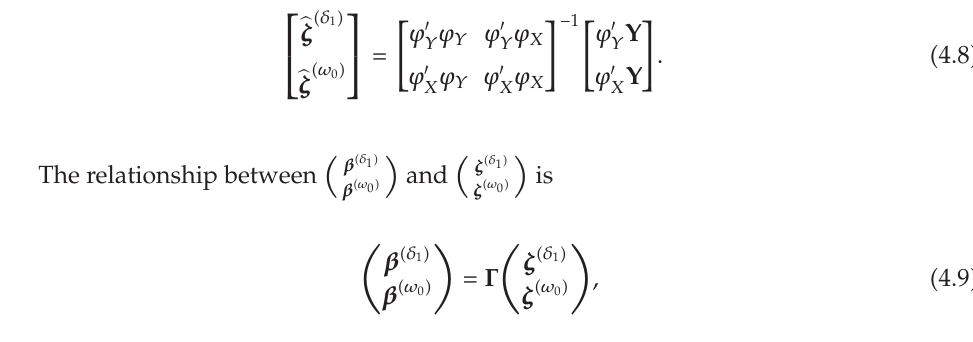
(cid:5) δ (cid:6) (cid:5) ω (cid:6) In (cid:5) 4.6 (cid:6) , ζ and ζ contain the coe ffi cients in the expansion (cid:5) 4.4 (cid:6) and γ contains 1 0 lines given by (cid:5) 4.5 (cid:6)